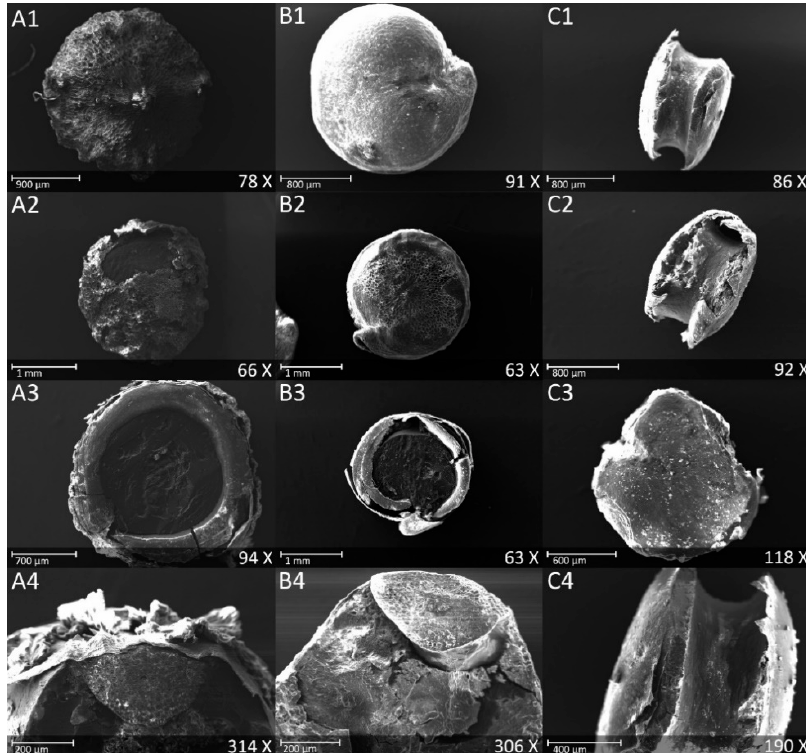
Figure 2. Scanning Electron Microscope images of quinoa seeds cv Titicaca. ( A ) Raw seeds: ( 1 ) Dorsal surface, ( 2 ) Ventral surface, ( 3 ) Cross section showing different seed layers, ( 4 ) Longitudinal section showing the embryo. ( B ) Polished seeds: ( 1 ) Dorsal surface, ( 2 ) Ventral surface with residual outer layer, ( 3 ) Cross section showing the embryo and the seed layers, ( 4 ) Longitudinal section showing the embryo. ( C ) Semolina: ( 1 ) Lateral view, ( 2 ) Lateral view showing residual layers and ( 3 ) Dorsal surface, ( 4 ) Lateral view showing the empty location of the embryo.